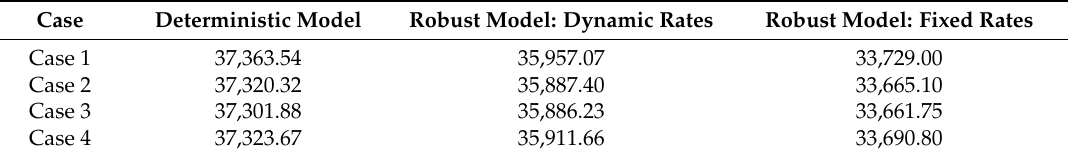
Table 6. Profit of the retail electricity provider (REP) in different cases (€).